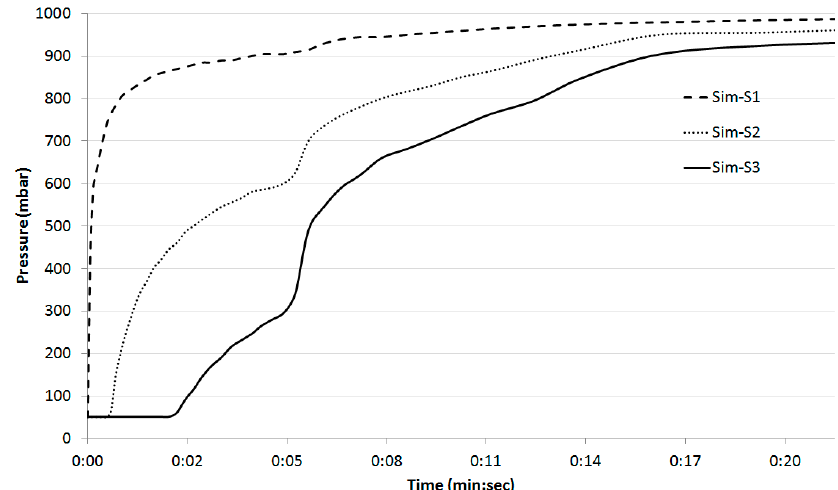
Figure 3. Analytical calculation of pressure inside the CFRP laminate based on Darcy’s law using RTM-worx